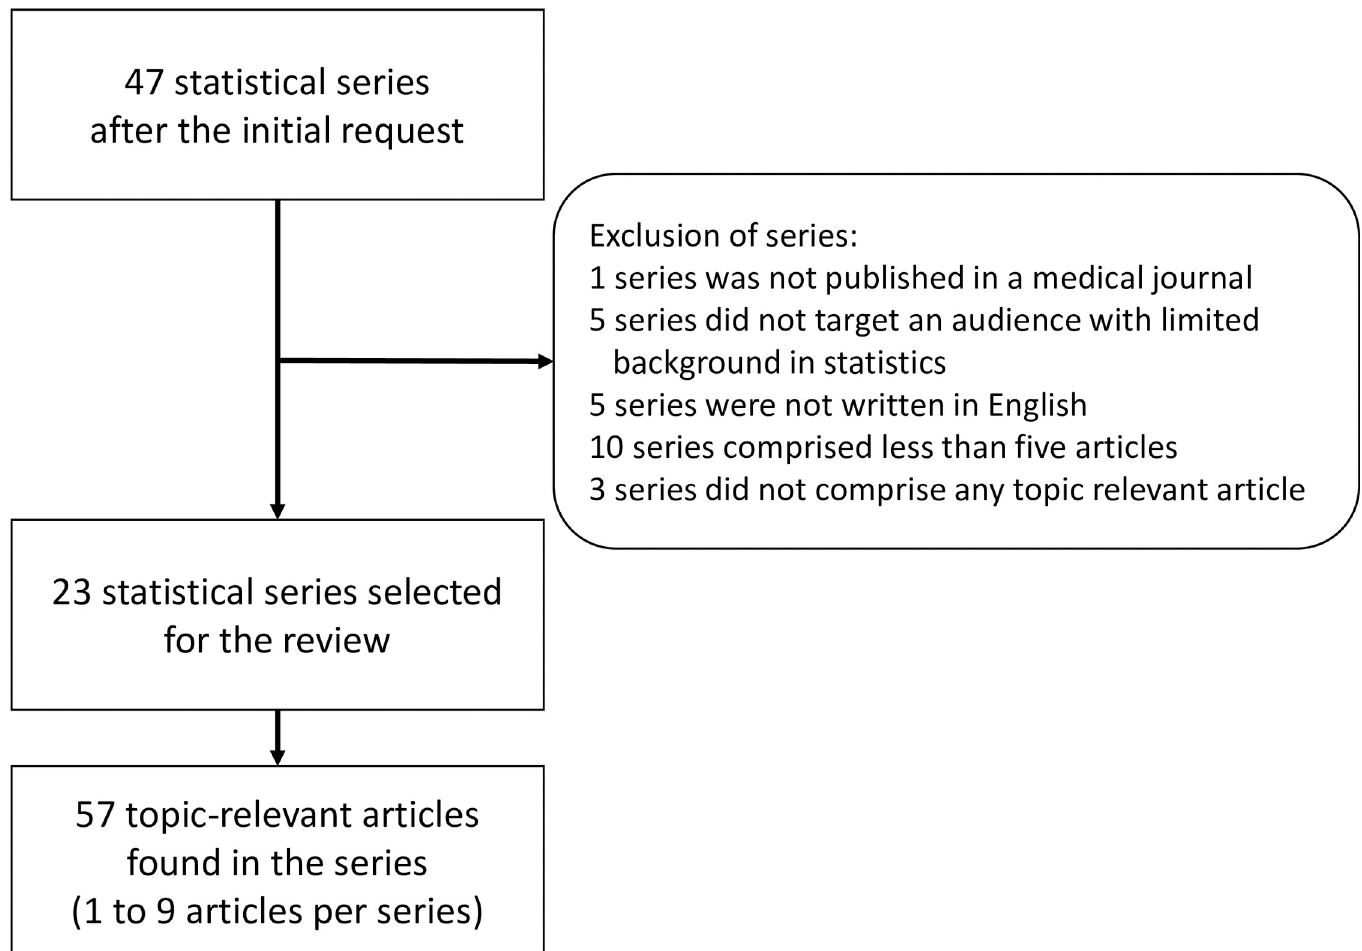
Fig 1. Flowchart of selection of statistical series and topic-relevant